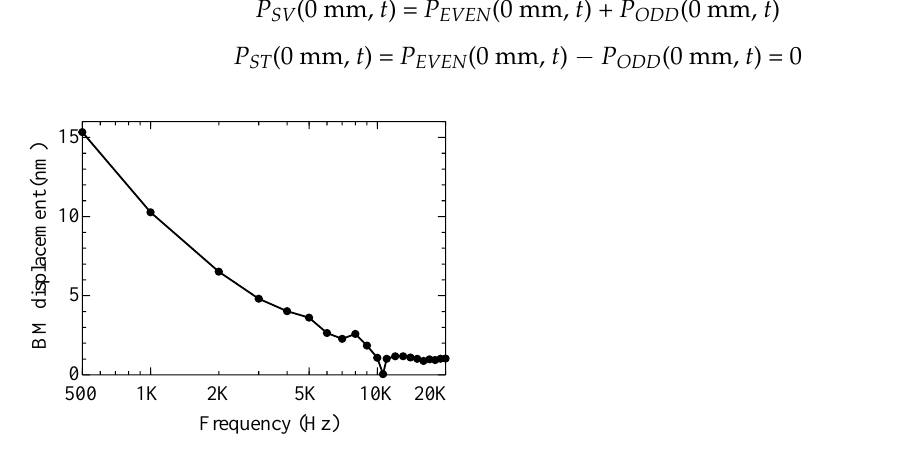
Figure 4. Frequency dependence of the displacement of the basilar membrane when a continuous sinusoidal plane wave of 1 Pa was excited at the oval window.